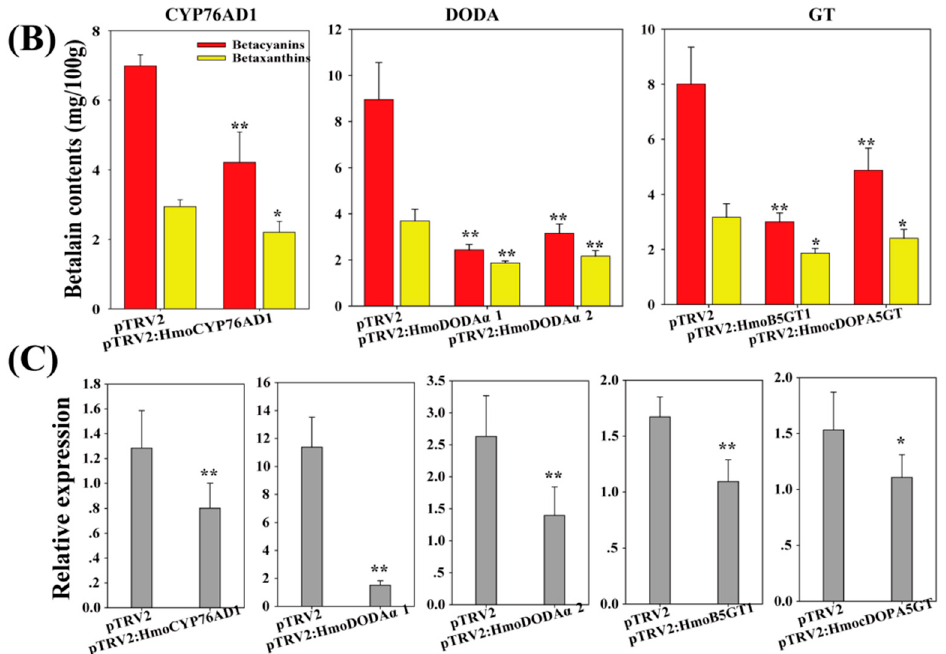
Figure 5. Virus-induced gene silencing (VIGS) phenotypes in pitaya. ( A ) Pitaya fruit ( left ) and ‘scale’ ( right ) at 14 d after inoculation. ( a , c , f ) TRV1/TRV2 empty vector–inoculated; ( b ) TRV1/TRV2-HmoCYP76AD1–inoculated; ( d ) TRV1/TRV2-HmoDODA α 1–inoculated; ( e ) TRV1/TRV2-HmoDODA α 2–inoculated; ( g ) TRV1/TRV2-HmoB5GT1–inoculated; ( h ) TRV1/TRV2-HmocDOPA5GT–inoculated. ( B ) Betalain con- tents of inoculation pitaya scales; ( C ) Gene expression of inoculation pitaya scale. **: p < 0.01, *: p < 0.05, Scale bars = 2